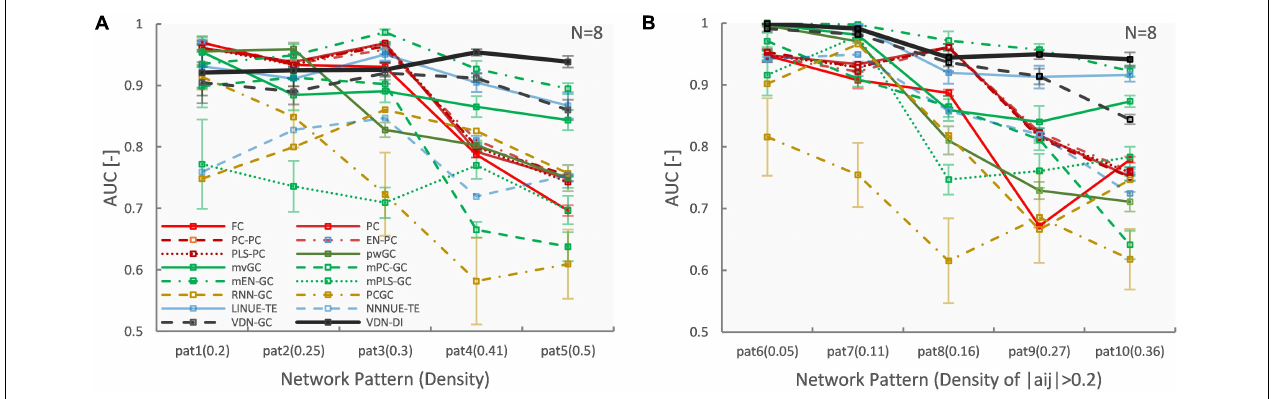
FIGURE 4 | (A) Network density (sparse pattern) vs. AUC result. Error bar shows standard error. (B) Network density (fully connected) vs. AUC